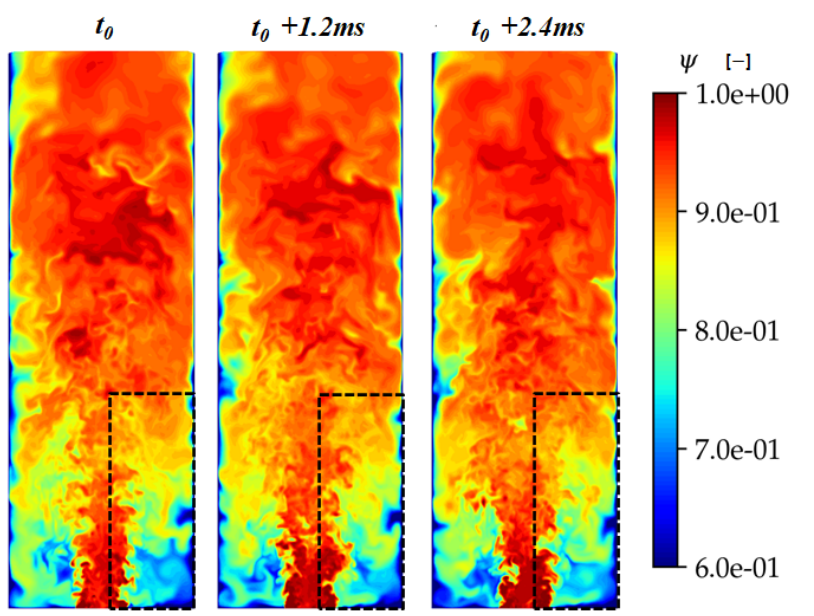
Figure 13. Instantaneous maps of heat loss field Ψ for various instants of time (from left to right ). The blacks dashed lines highlight the recirculating gas cooling during the upstream